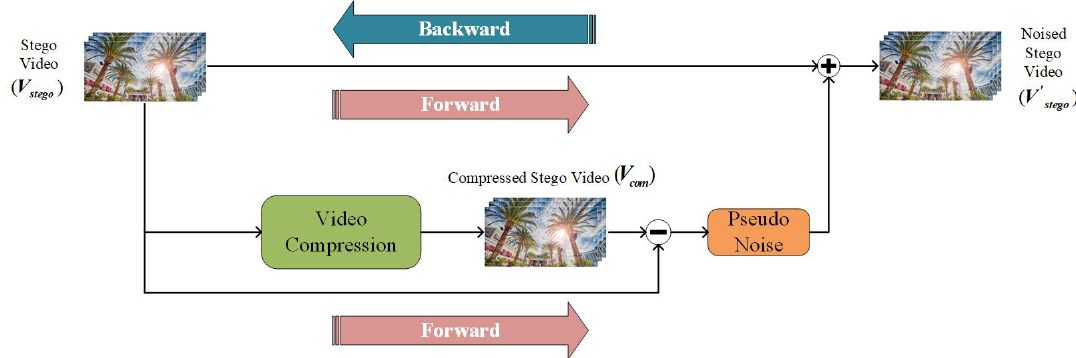
Figure 6. The flow chart of noise layer.